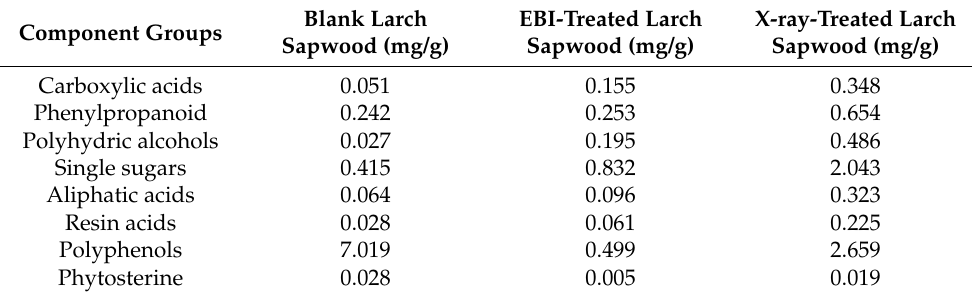
Table 2. Main component groups in acetone extracts of different treated larch sapwood samples by